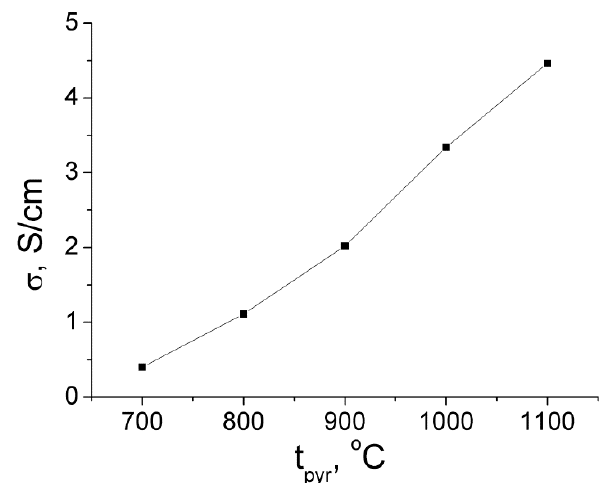
Figure 5. The dependence of specific electronic conductivity of carbon aerogels on pyrolysis Figure5. Thedependenceofspecificelectronicconductivityofcarbonaerogelsonpyrolysistemperature. temperature.